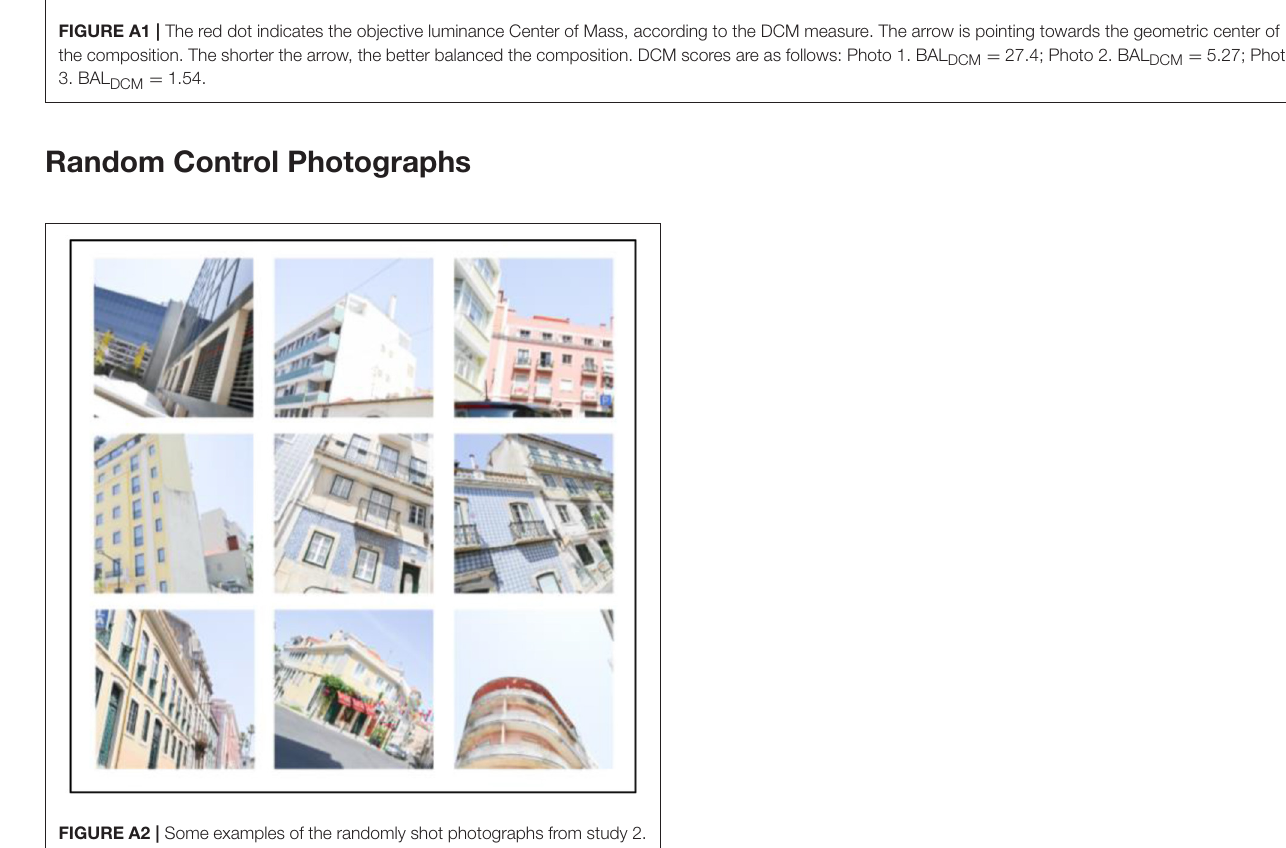
27.4; Photo 2. BAL DCM 5.27; Photo = =